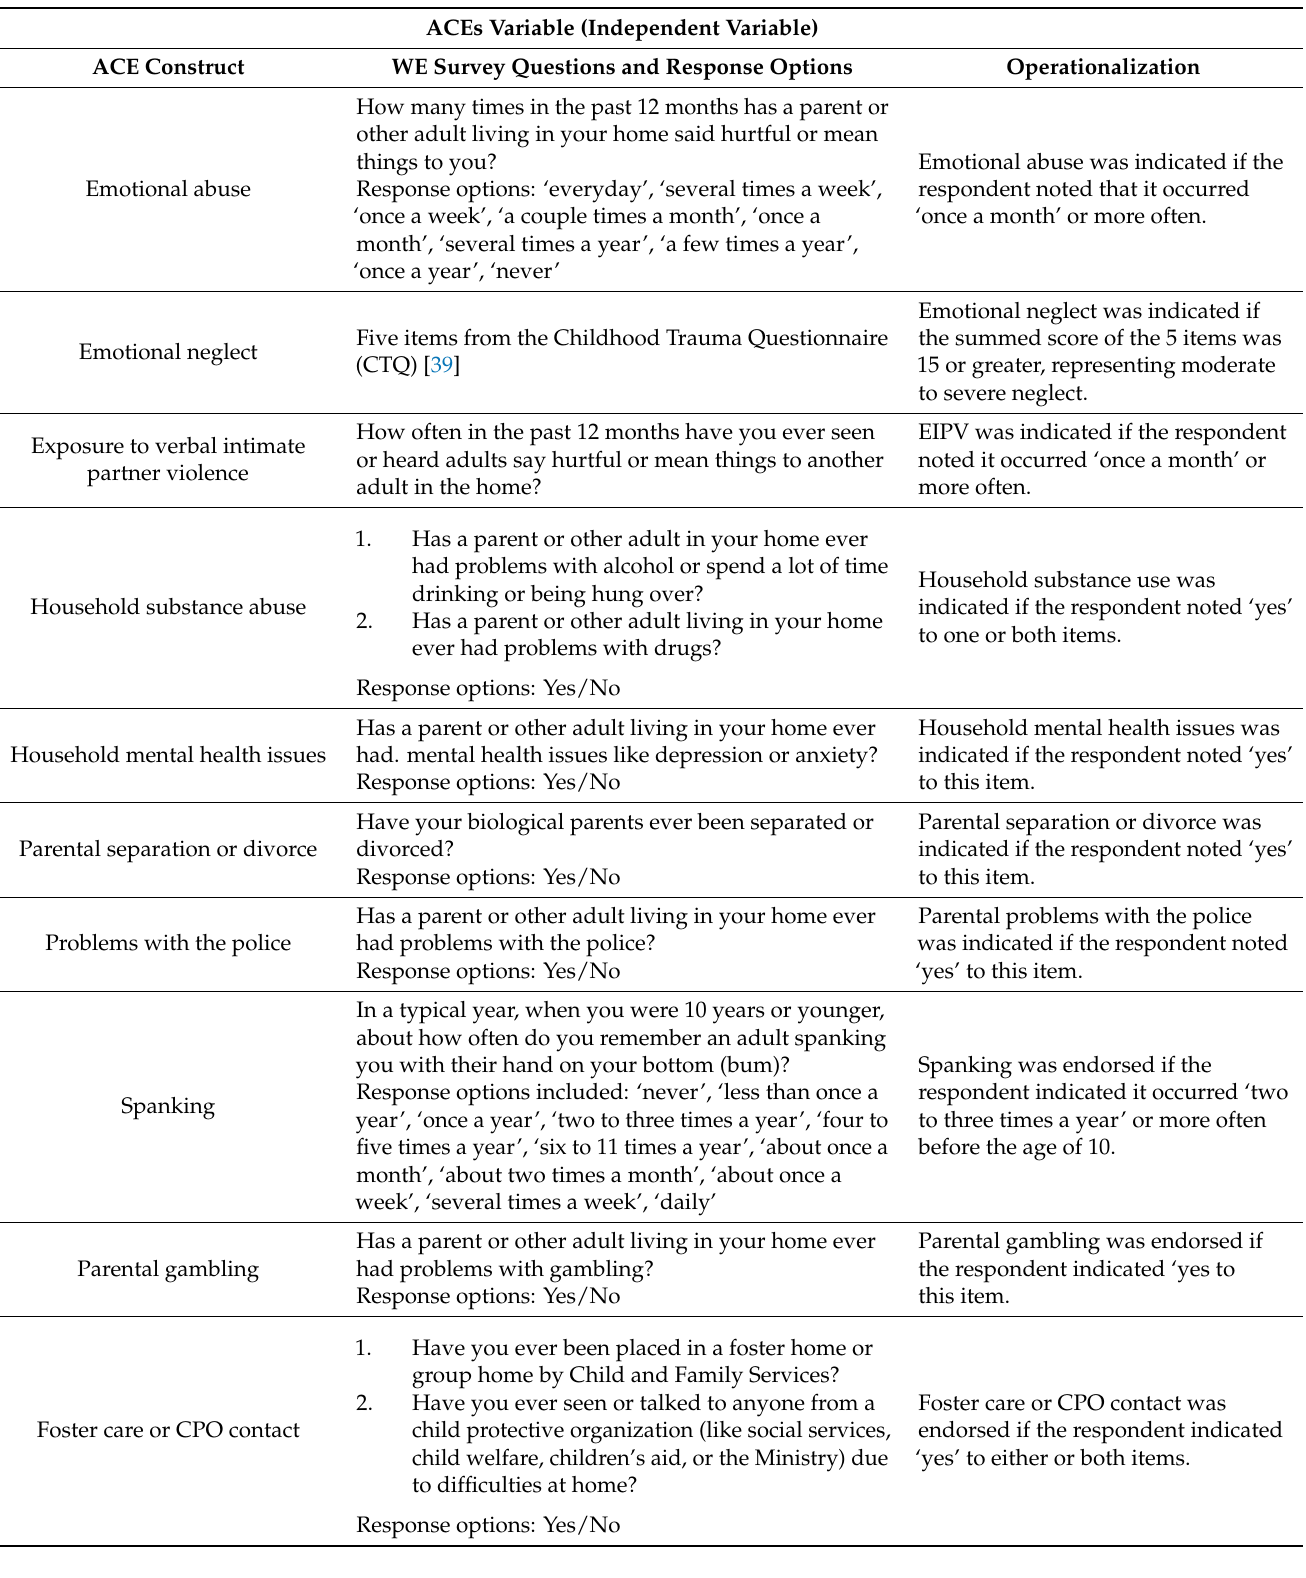
Table A1. Description of Study Measures and Operationalization of